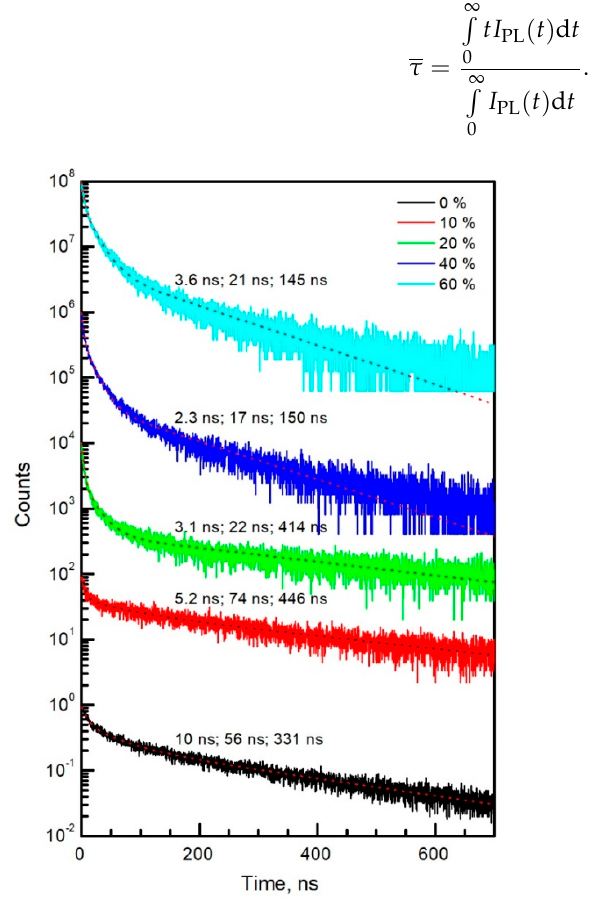
Figure 9. PL decay transients of the perovskite layers with different cesium concentration. Dotted lines are fittings using Equation (2) with i = 3.